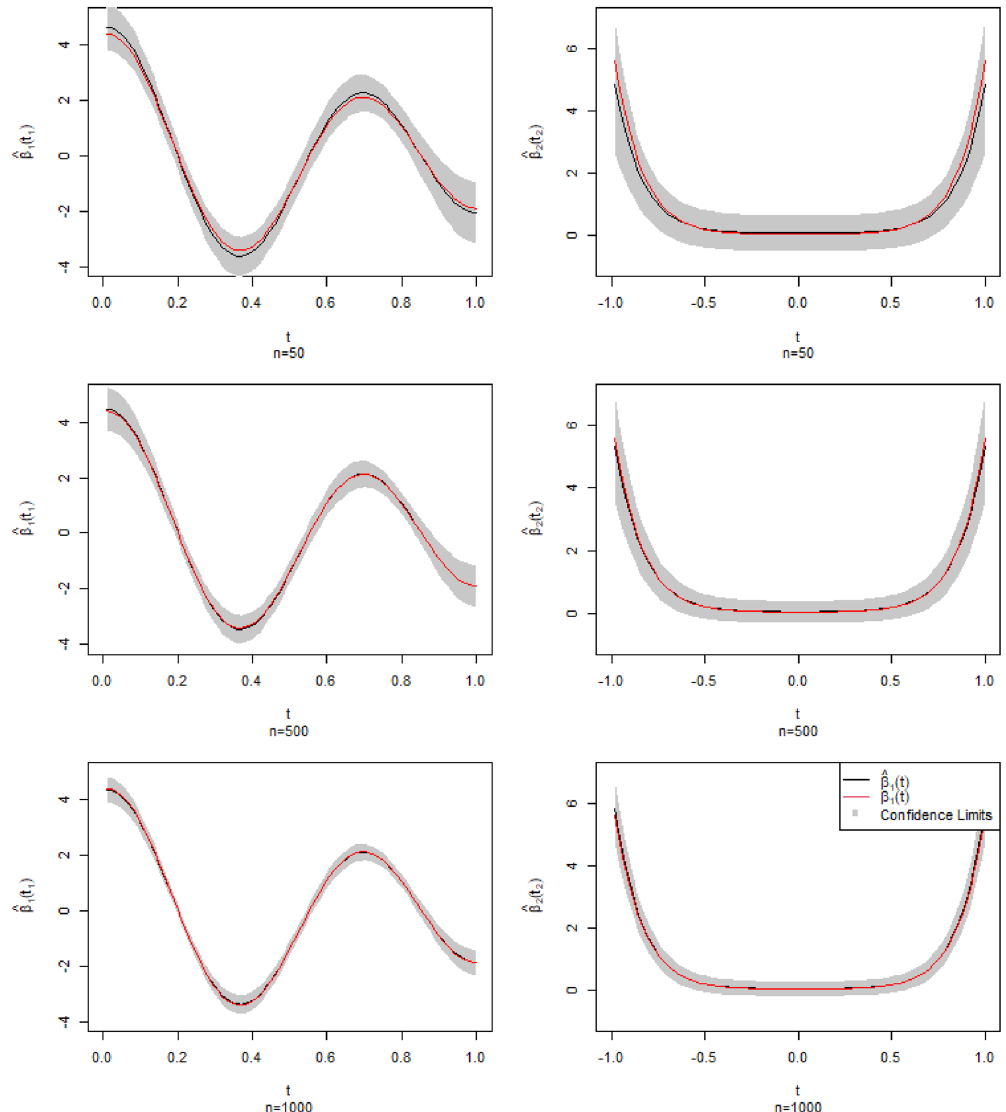
Figure 2. 95% confidence band for the estimator ˆ β 1 ( t 1 ) and ˆ β 2 ( t 2 ) under different sample sizes. The red curves are theoretical β 1 ( t 1 ) and β 2 ( t 2 ) , the black curves are the corresponding estimation and it’s the result of a simulation, the gray parts are the 95% confidence